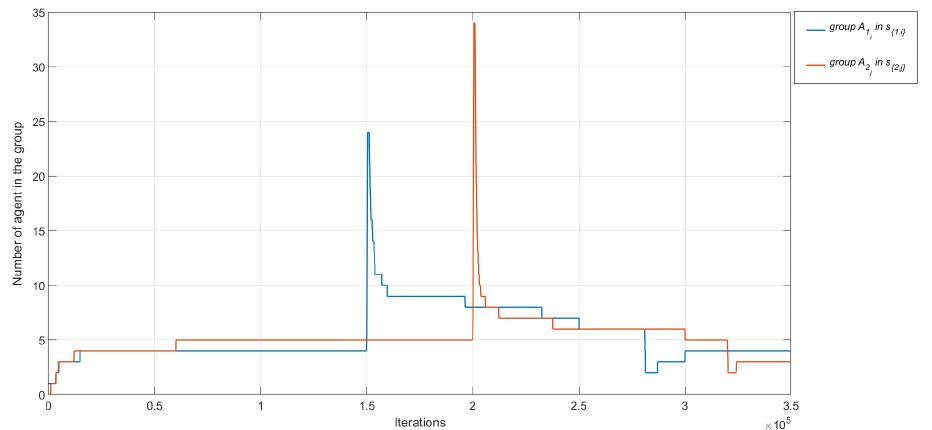
Figure 16. The exploration of heterogeneous space with the artificial addition and removal of the agents to and from A 1 and A 2 groups: Pmax { f , k , v } = Pa { f , k , v } = Pr { f , k , v } = 400, TCa { f , k , v } = 0,